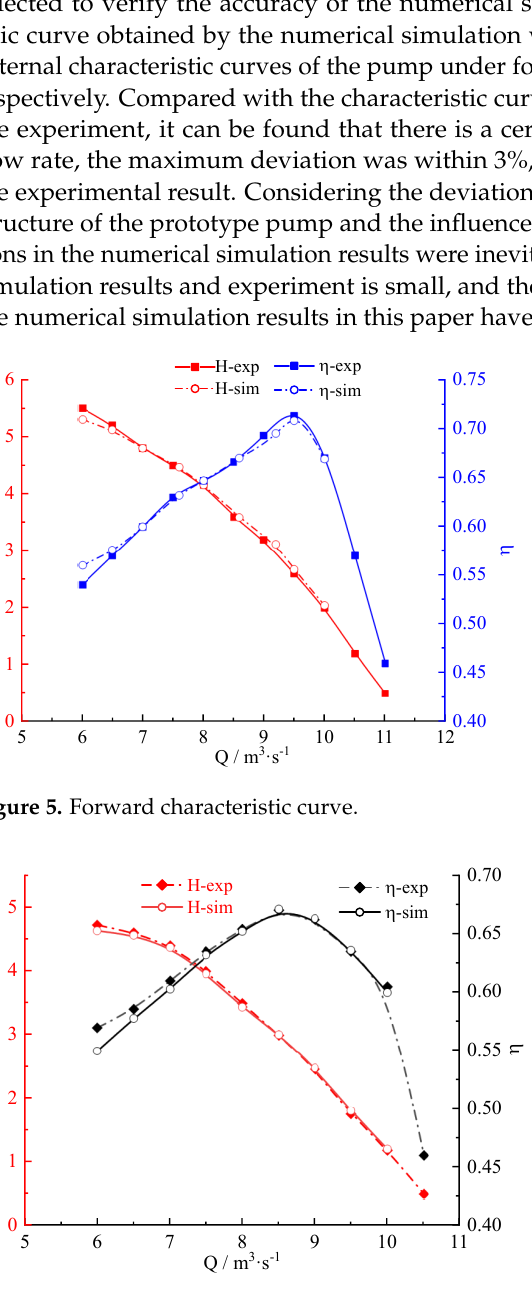
Figure 6. Inverse characteristic curve.